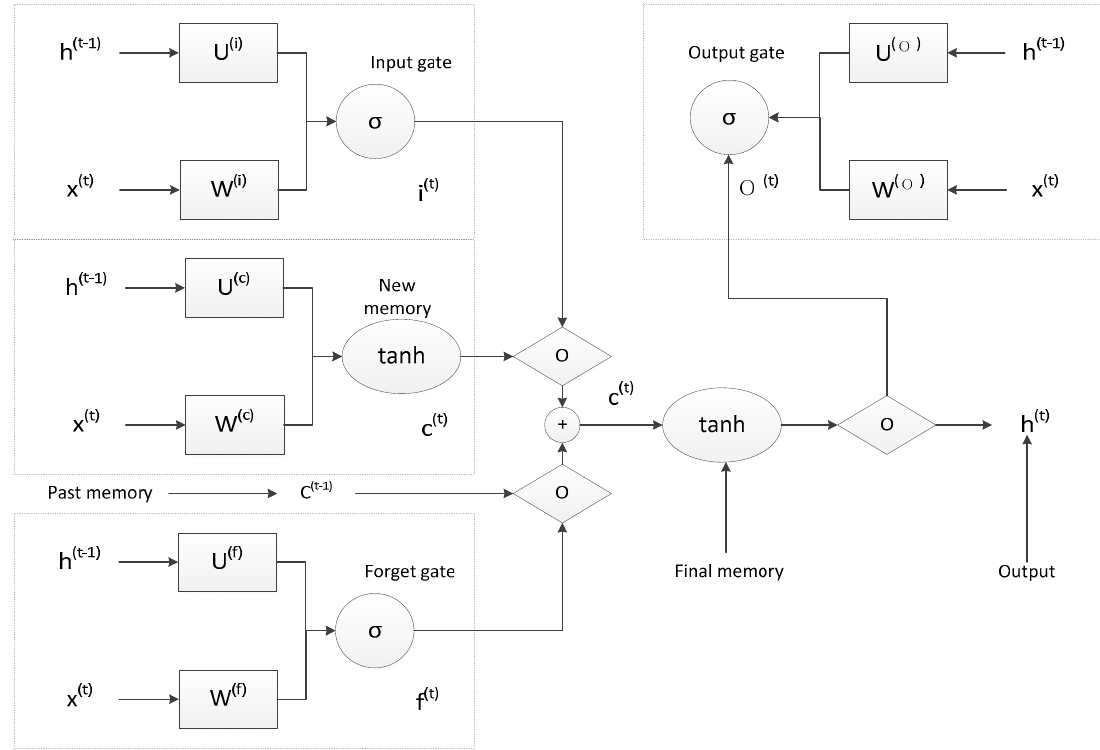
Figure 5. Long-term and short-term memory output structure diagram. Table 5. Forecast of groundwater hydro-chemical data during 2019–2021.